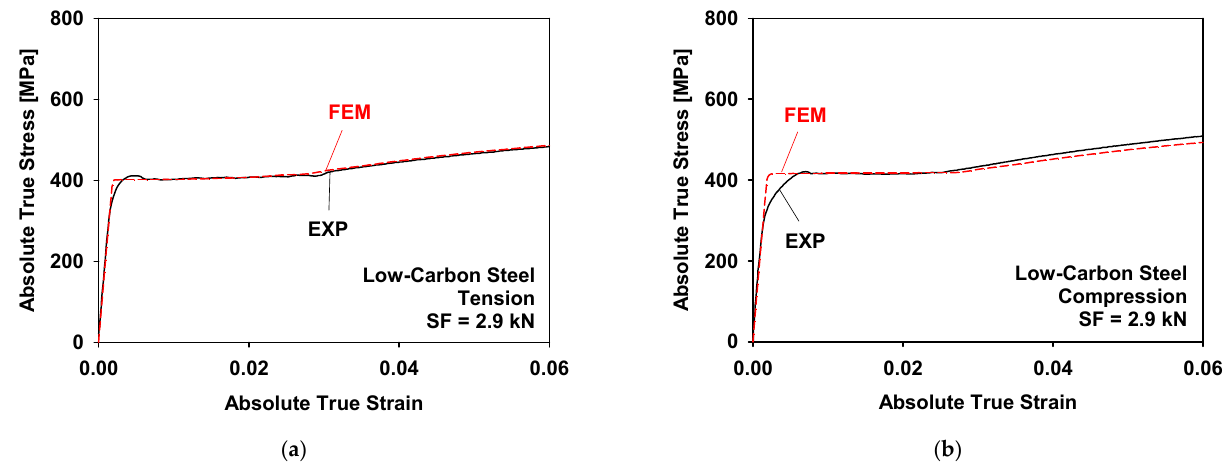
Figure 8. Comparison of the measured and FE calculated absolute true stress–strain curves of the low ‐ carbon steel: ( a ) tensile and ( b ) compressive tests.